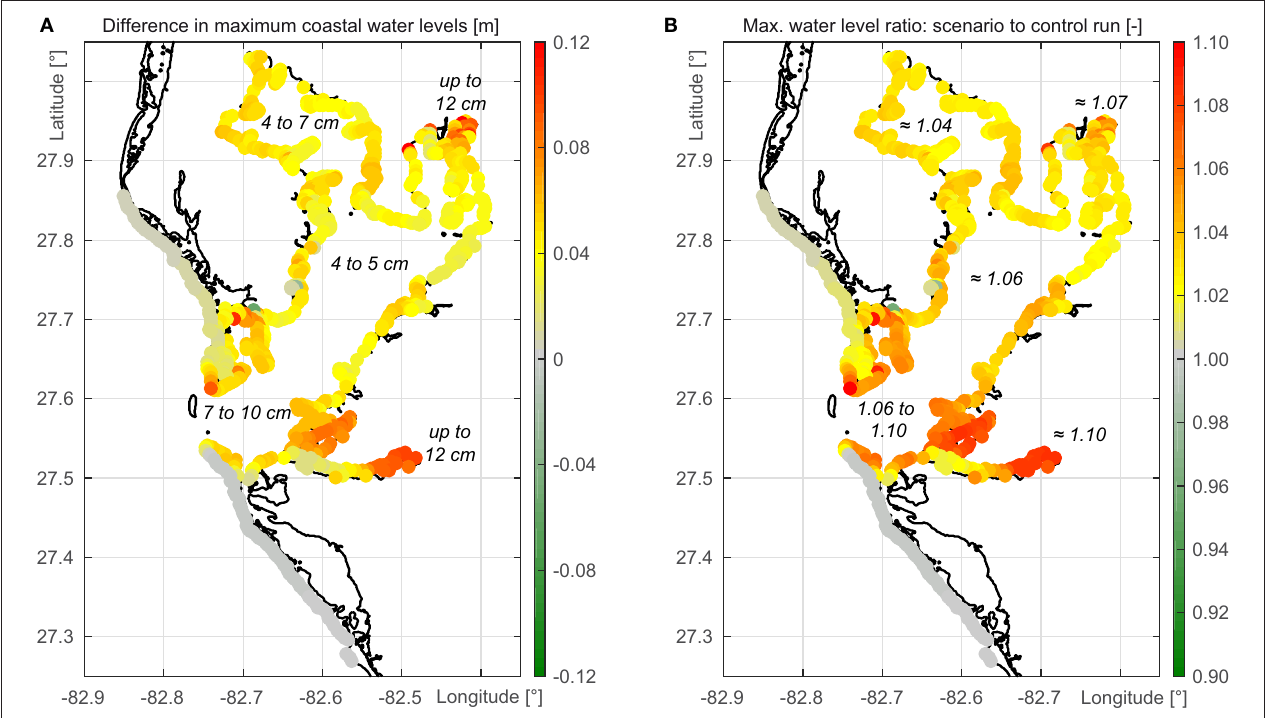
FIGURE 8 | Difference in maximum water levels along the coastline (A) and the difference expressed as ratio between scenario and control run simulation (B).